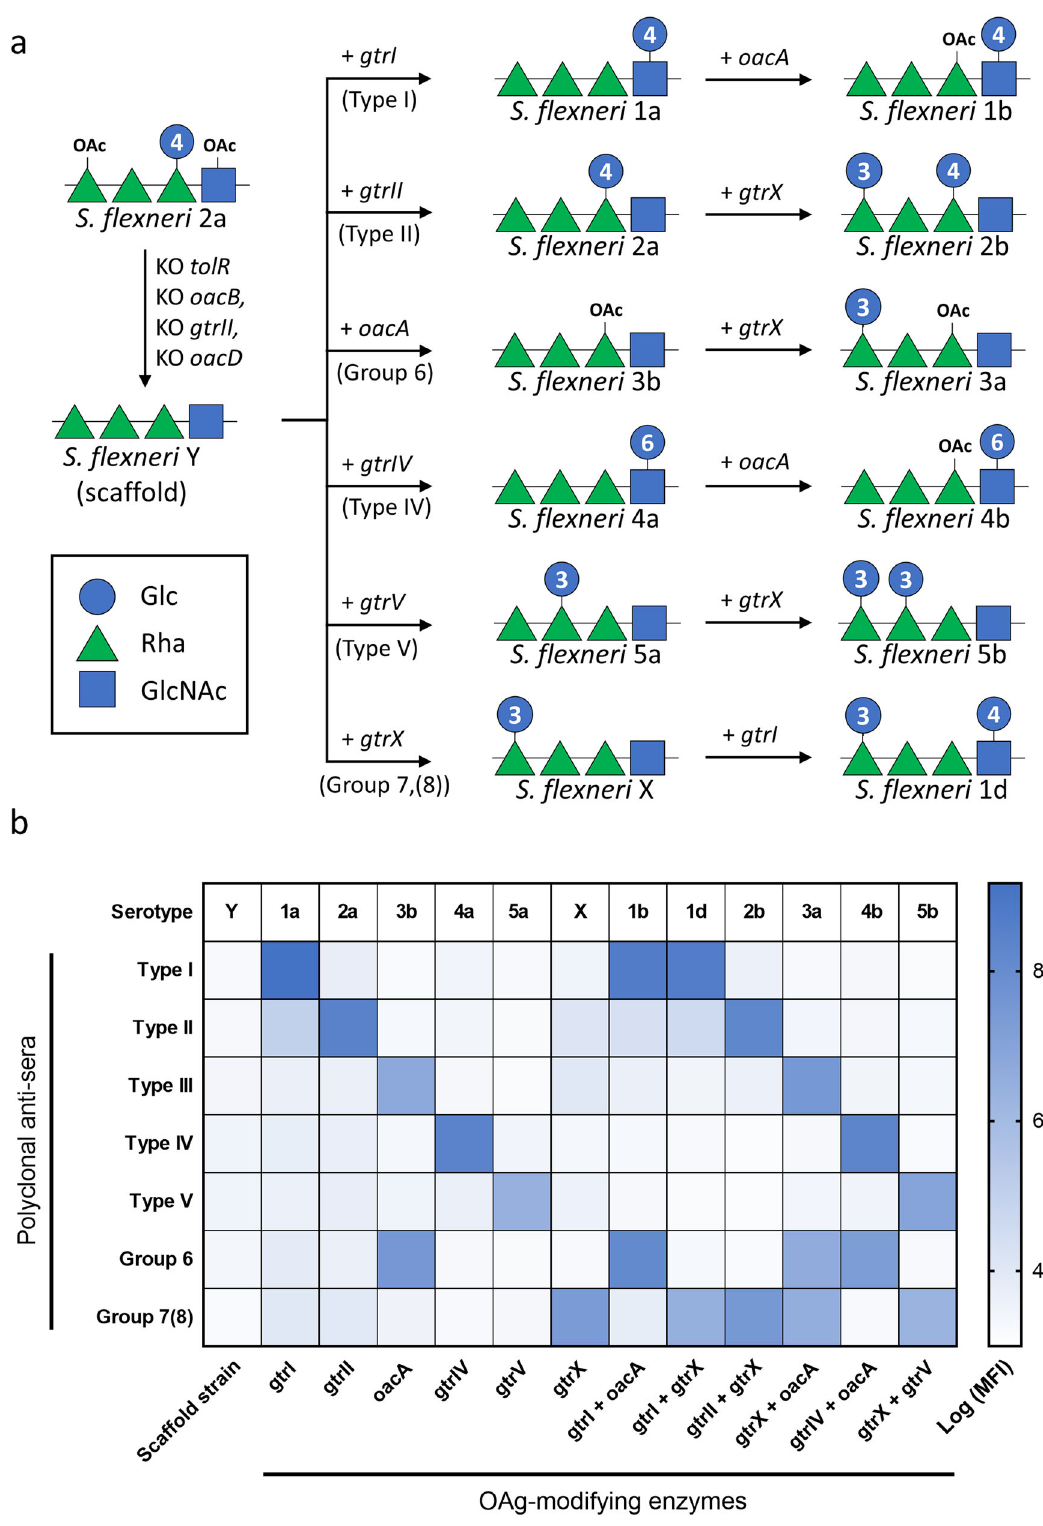
Fig. 1 Conversion of serotype Y scaffold strain to different S. fl exneri serotpes. a Engineering strategy and resulting OAg structures as veri fi ed by 1 H-NMR. The numbers inside the blue circles refer to the position of the linkage of glucose to the RU. b FACS typing analysis of all strains with Denka Seiken monovalent antisera kit. Results are shown as a heat-map of log-transformed mean fl uorescence intensities